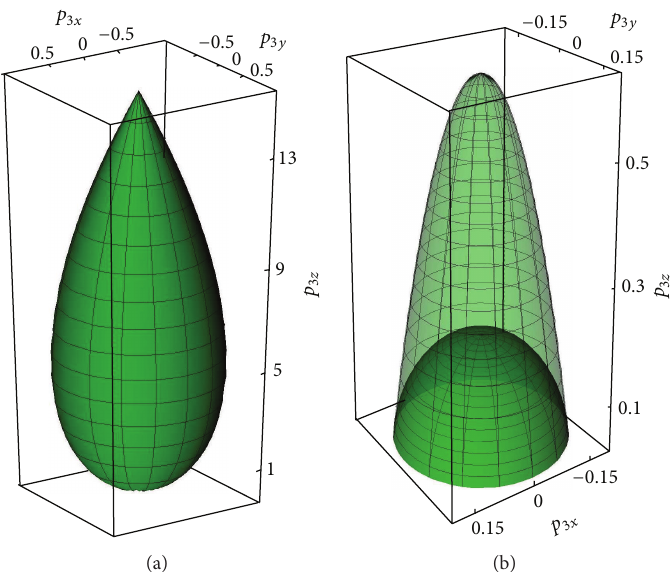
Figure 2: (a) Region of allowed outgoing momenta ⃗𝑝 3 for the decay of an incoming superluminal neutrino with 𝐸 ] = | ⃗𝑝| V ] . The neutrino is incoming along positive 𝑧 -axis ( 𝑝 1𝑧 = 15 ). The boundary of allowed ⃗𝑝 3 vectors constitutes a distorted ellipsoid with a “sharpened tip,” obtained as a solution of setting 𝑞 2 = 0 in (12). (b) Region of allowed ⃗𝑝 3 vectors for an incoming tachyonic neutrino with 𝑝 1𝑧 = 62 and = −(0.2) 2 , producing an electron-positron pair of mass 𝑚 −𝑚 2 ] correspond to evanescent waves and are thus to be excluded [6].